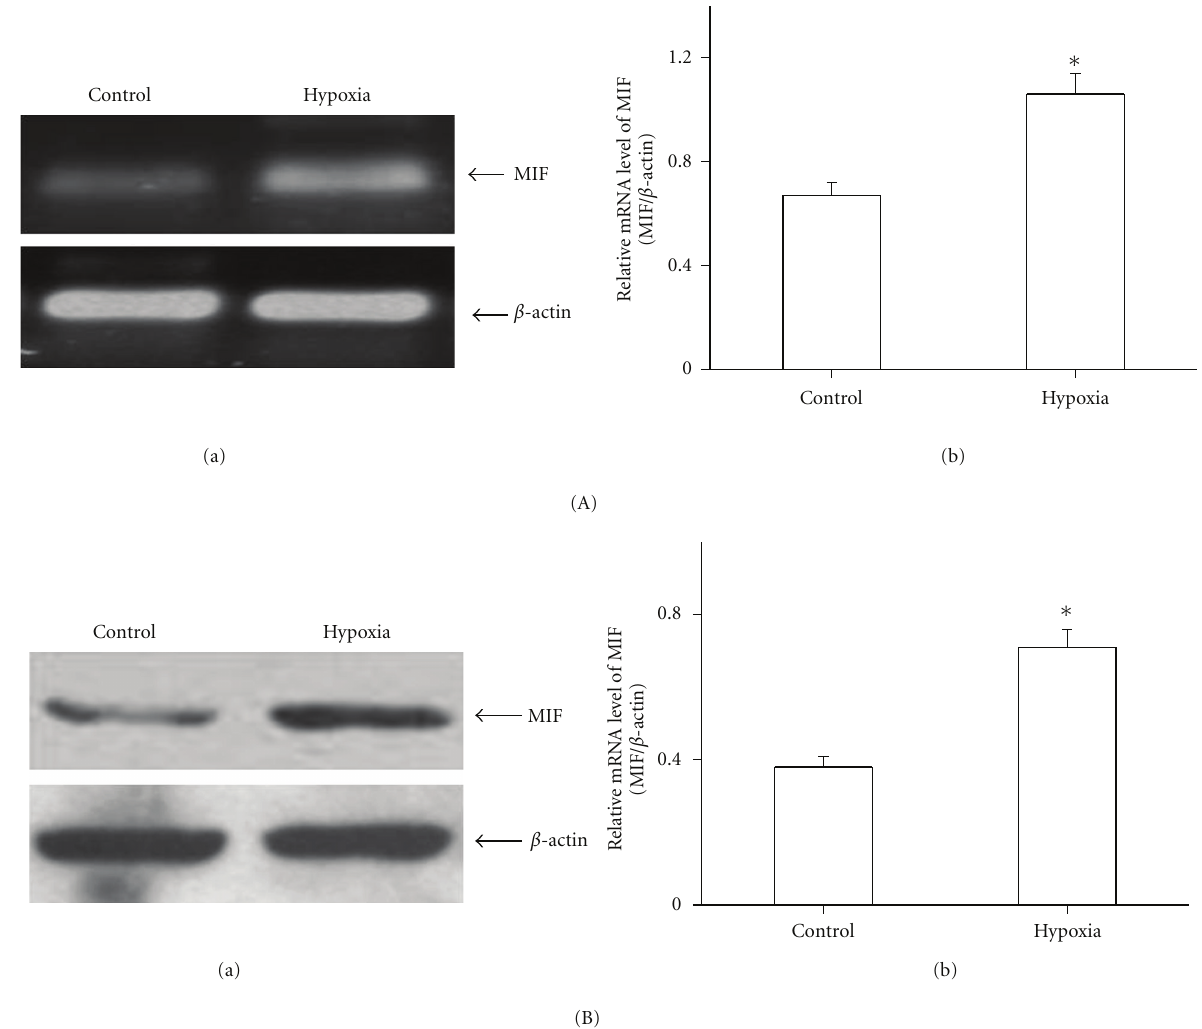
Figure 1: MIF expression in rat lung homogenates. (A) MIF expression was measured by RT-PCR before and after hypoxia exposure. There was a marked upregulation of MIF in the lungs from hypoxic rat (a). Bar graph showed MIF mRNA levels obtained from quantitative densitometry analysis (b). (B) Western blot analysis demonstrated that MIF protein was increased in rat lung homogenates after hypoxia exposure (a). Bar graph showed MIF protein levels obtained from quantitative densitometry analysis (b). n = 5. ∗ P < 0 . 05 versus control.